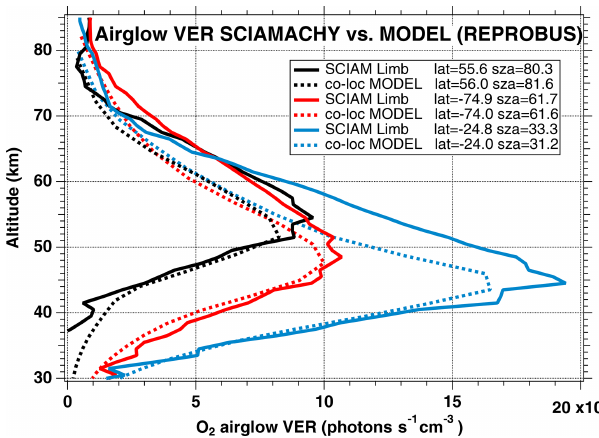
Figure 12. Comparison of SCIAMACHY and REPROBUS air- glow VER profiles for 3 January 2007. Three profiles were drawn at SZAs of about 30, 60, and 80 ◦ , indicated in the legend. The SCIAMACHY profiles are plotted as solid lines and the geolocated REPROBUS profiles are plotted as dashed